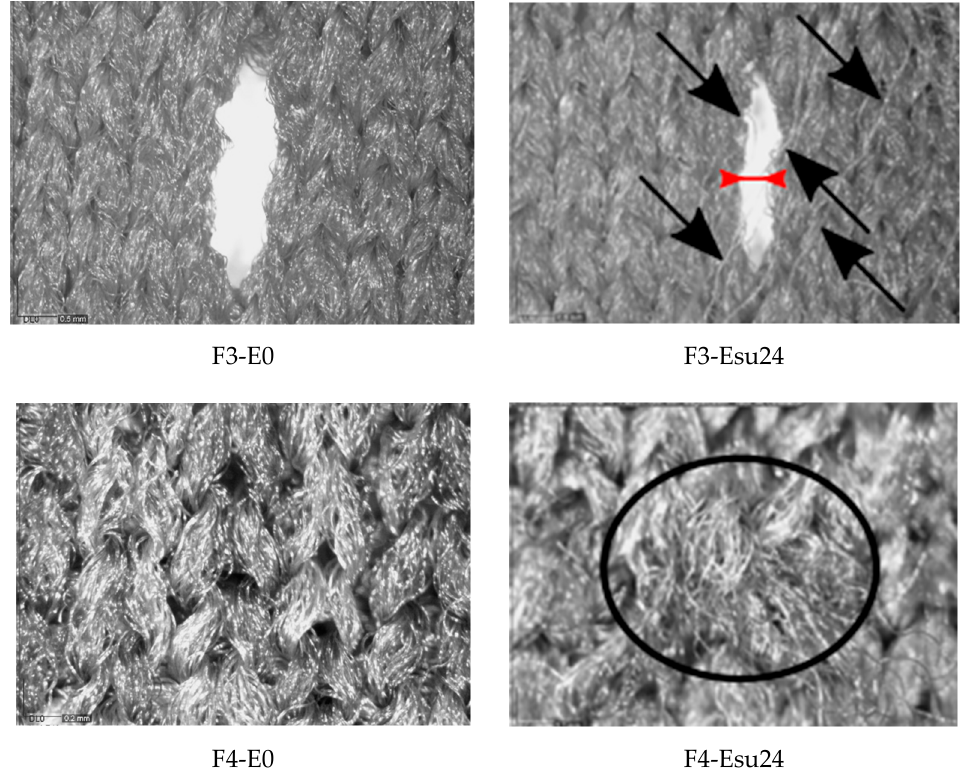
Figure 4. The microscopic images of polymer materials F3 and F4—non-exposed (E0) and after the longest exposure to aging, including the exposure to the sun (Esu24).